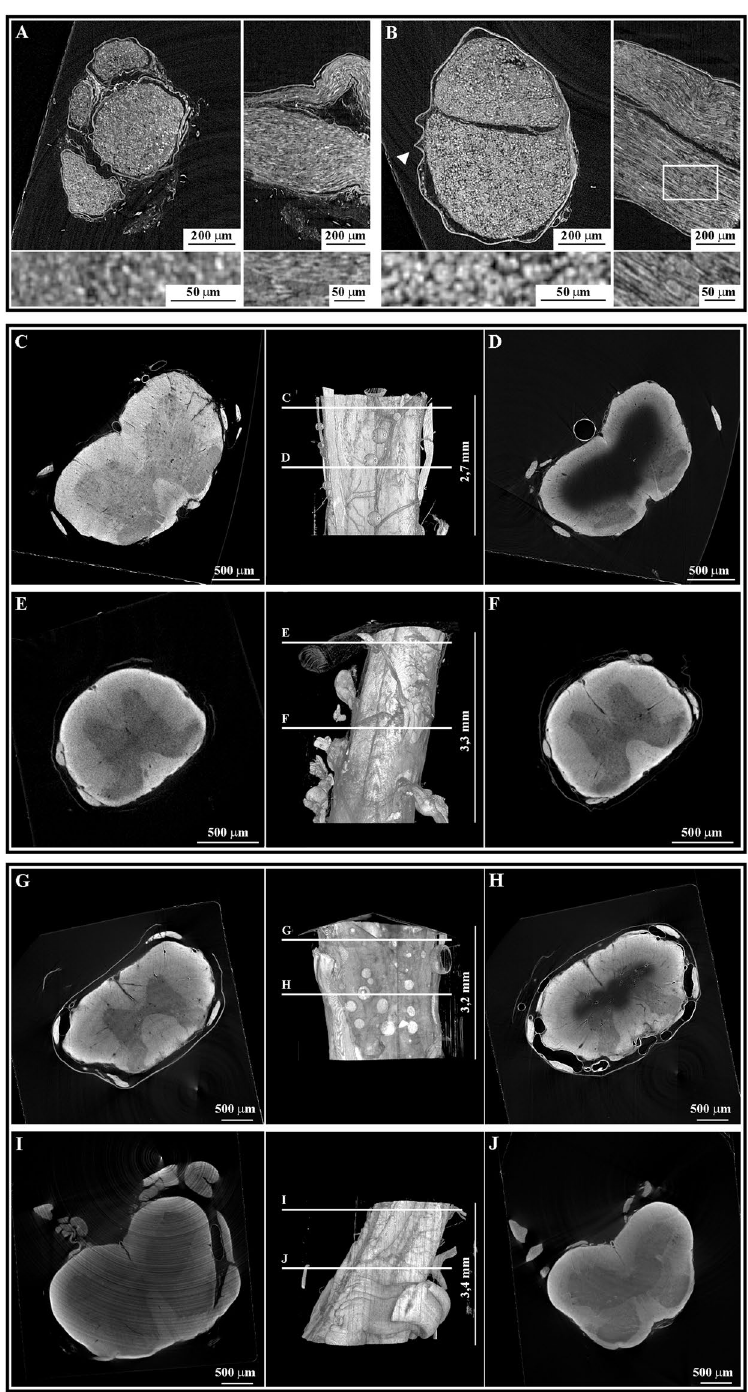
Figure 2. The protocol optimization: micro-CT results. Upper panel: sciatic nerves prepared with ( A ) the ideal- size or ( B ) the optimized small-size protocol. Middle panel: mice spinal cord tracts prepared with ( C , D ) the small-size or ( E , F ) the optimized medium-size protocol. Lower panel: rat spinal cord tracts prepared with ( G , H ) the medium-size or ( I , J ) the optimized large-size protocol. For sciatic nerves are reported representative xy and yz projections and their higher magnification in the bottom lines. For mice and rats spinal cord tracts are shown a representative virtual slice of the top part of the sample, a 3D rendering of the whole sample and a deeper virtual